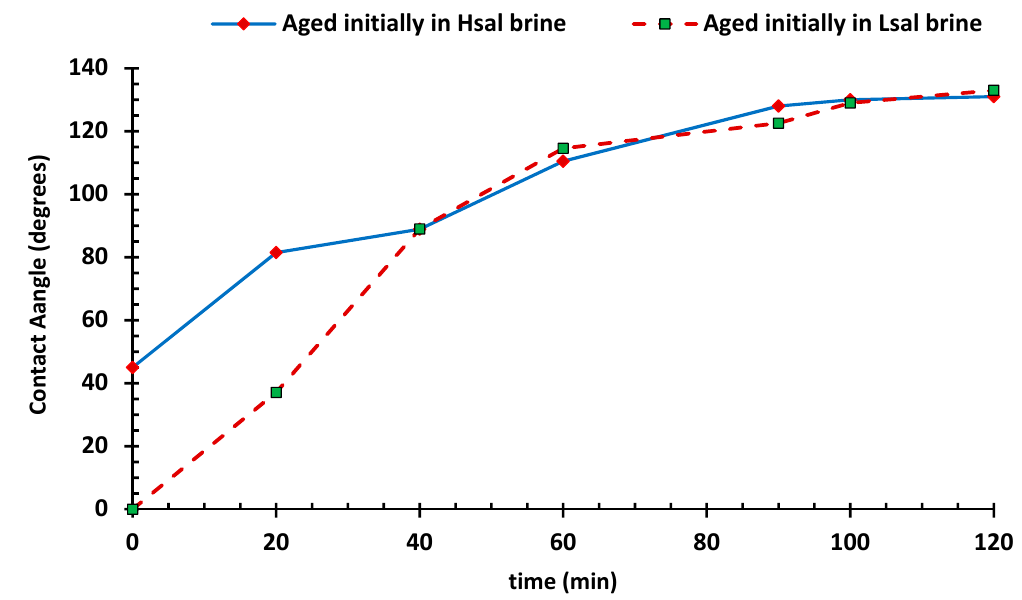
Figure 3. Contact angle of the oil/brine/rock versus time for primary aged calcites in high-salinity brine (Hsal) and Low-salinity brine (Lsal).